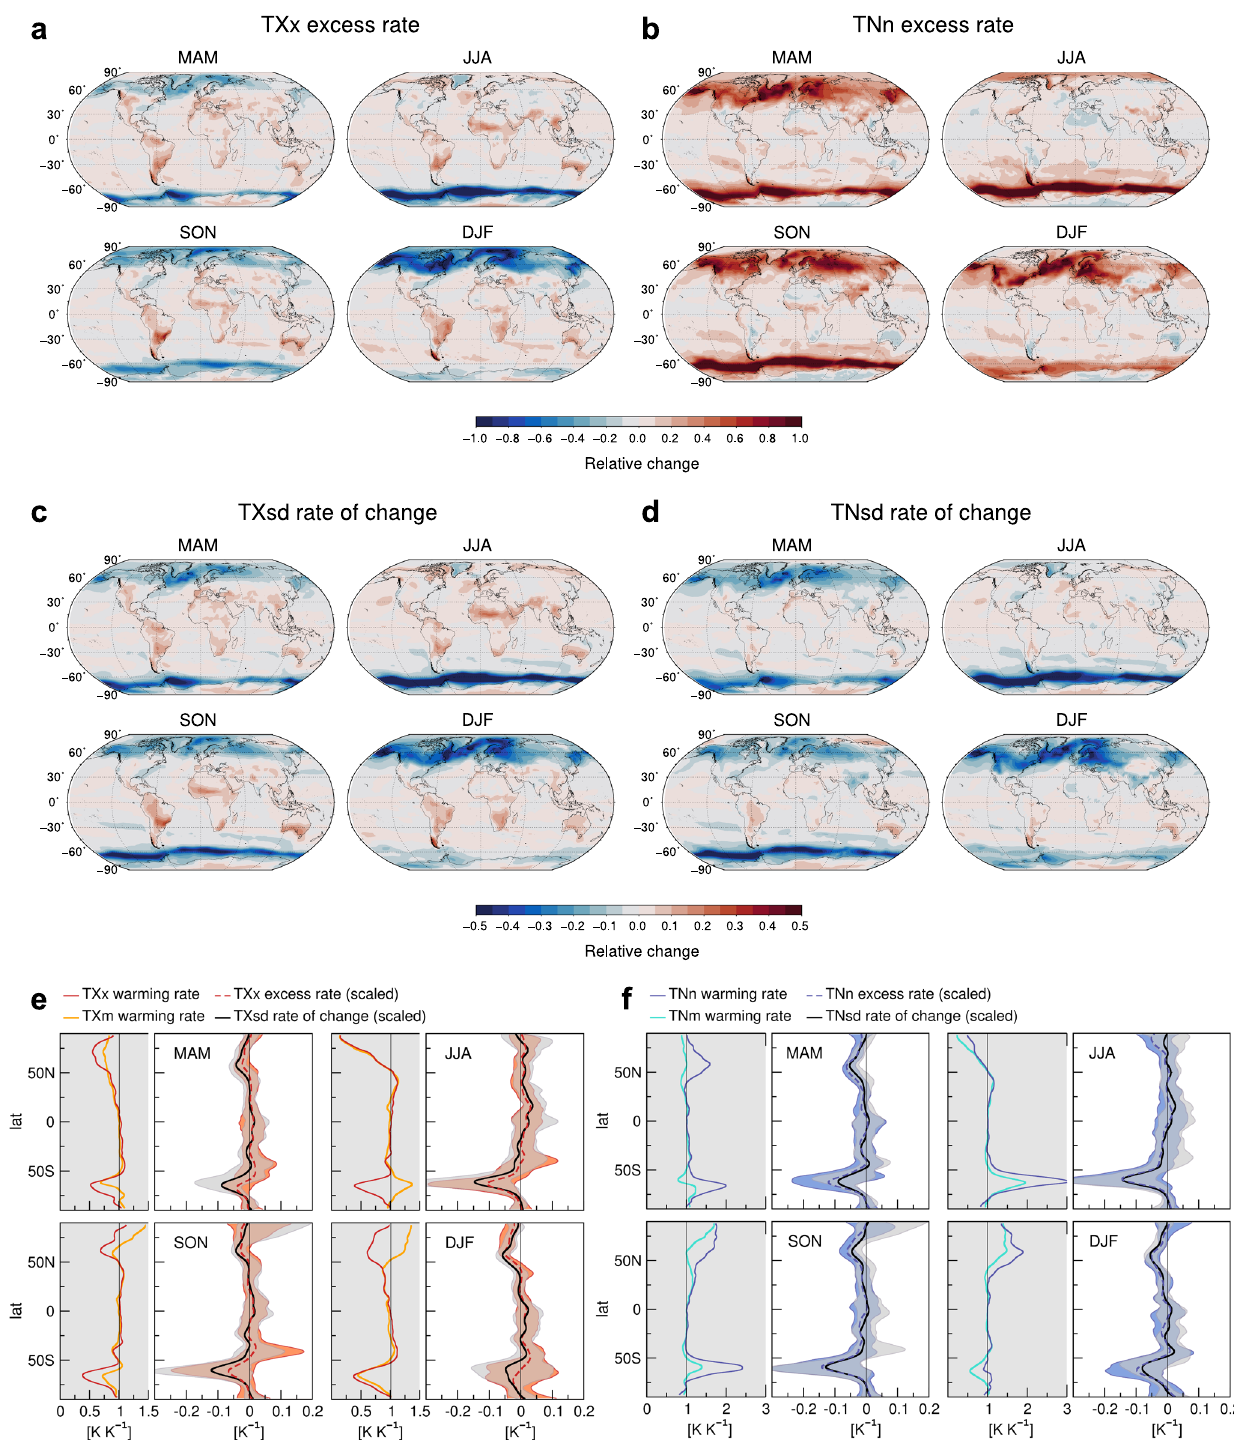
Fig.3|Excessratesandhighermoments.a , b Excesswarmingratesofthehottest days ( TXx ) and the coldest nights of every season ( TNn ) respectively, that is, ( Δ TXx − Δ TXm )/ Δ T and ( Δ TNn − Δ TNm )/ Δ T where TXm denotes the seasonal day- time mean, TNm the seasonal nighttime mean and T the annual mean. MAM denotes March-April-May, JJA June-July-August, SON September-October- November and DJF December-January-February. c , d Seasonal rates of change in standard deviation, Δ TXsd / Δ T and Δ TNsd / Δ T, respectively. e , f Left panels: com- parison between e zonal-mean TXx and TXm warming ratesand f between those of TNn and TNm . Rightpanels:comparisonbetween e zonal-meanscaled excess rates